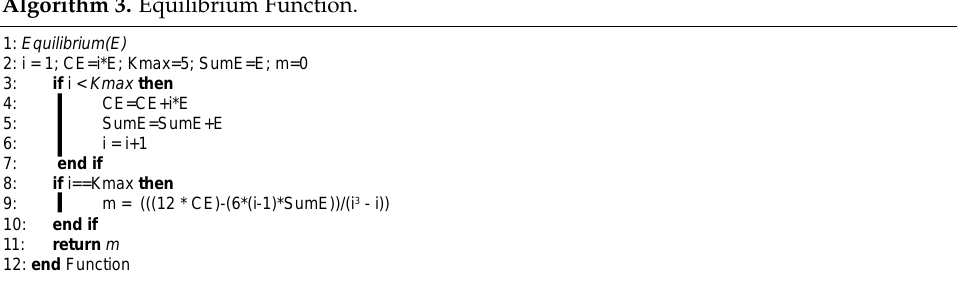
Algorithm 2 GRSA algorithm Procedure